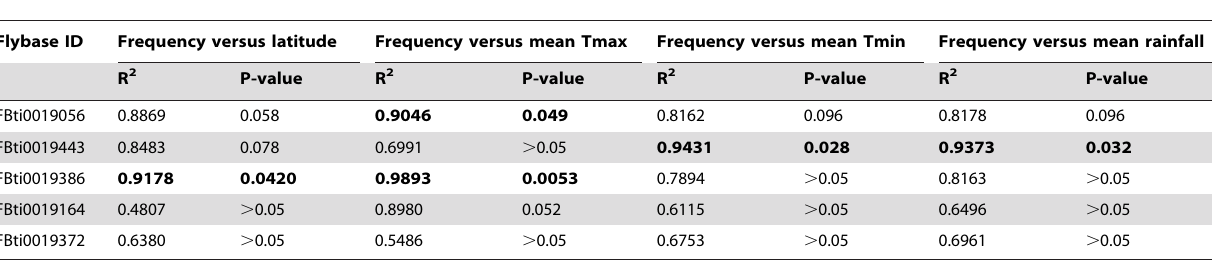
Table 2. Regression analysis examining associations between five TEs sampled in four Australian populations and different environmental